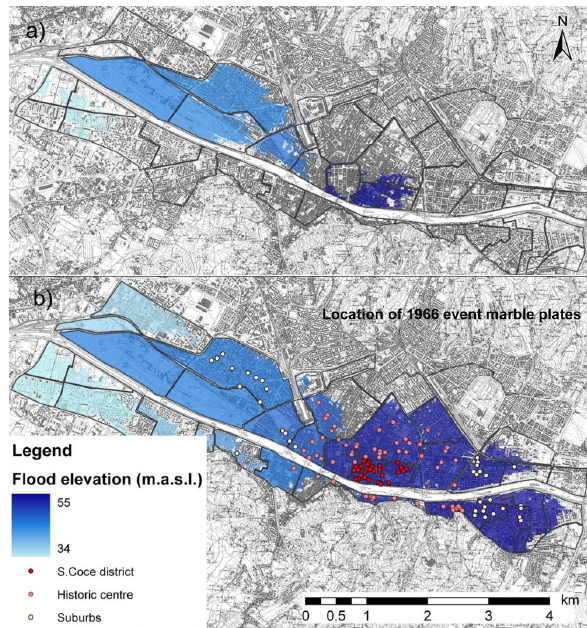
Figure 5. Maximum flood elevation in Florence for the 100 year flood (a) and 200 year flood 2 Fig. 5. Maximum flood elevation in Florence for the 100yr flood (a) (b). Panel (a) clarifies that in presence of high slopes close to the river banks these areas are 3 and 200yr flood (b) . (a) clarifies that in presence of high slopes supposed being of flow transit and consequently not flooded. Panel (b) also shows the 4 close to the river banks these areas are supposed to be of flow transit and consequently not flooded. (b) also shows the location of the location of the historic marble plates reporting the maximum flood depth of the 1966 flood. 5 historic marble plates reporting the maximum flood depth of the Different symbols are used for different study areas: red for the S.Croce district, pink for the 6 1966 flood. Different symbols are used for different study areas: whole downtown, white for later developed suburbs. 7 red for the St. Croce district, pink for the whole downtown, white for later developed